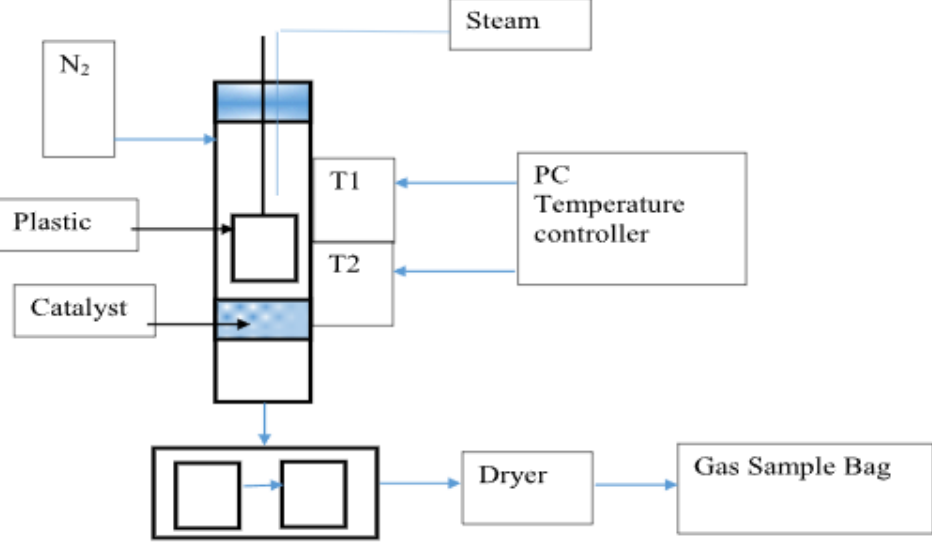
Figure 5. Schematic diagram of the pyrolysis–catalysis process of plastic waste.